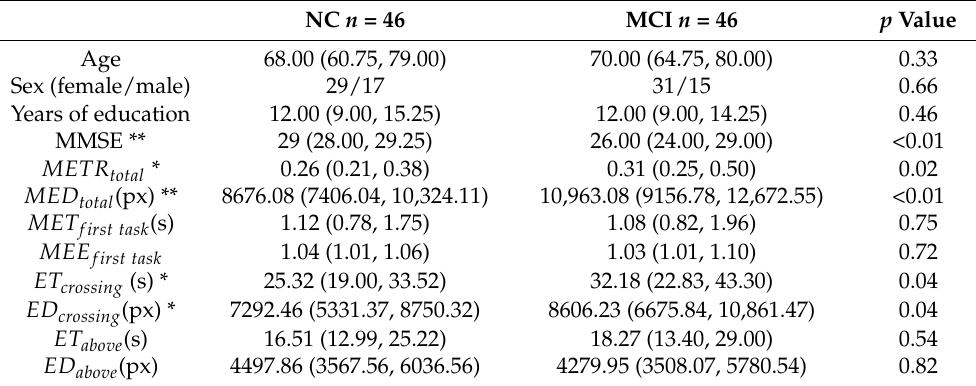
Table 4. Participants’ demographics and differential analysis of digital biomarkers and mini-mental state examination (MMSE) scores between the NC and MCI groups.